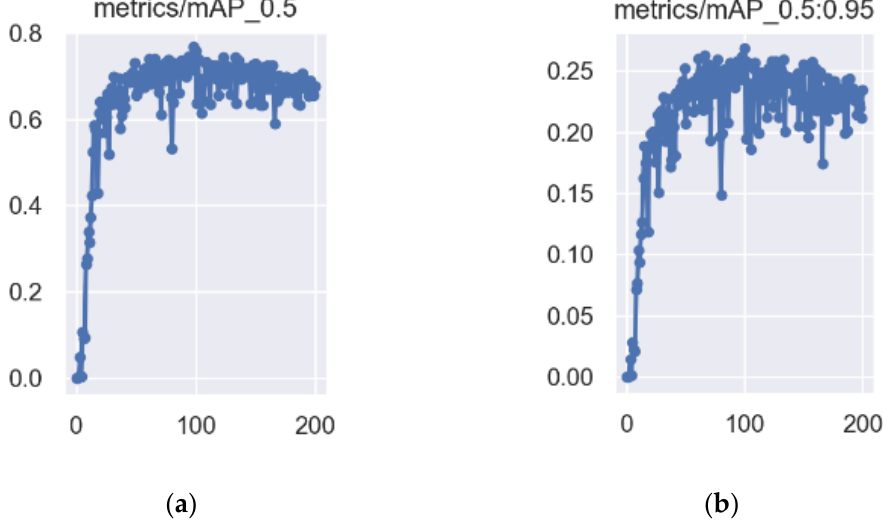
Figure A9. The change of mean average precision (mAP) of YOLOV5m: ( a ) mAP_0.5; ( b ) mAP_0.5:0.95.